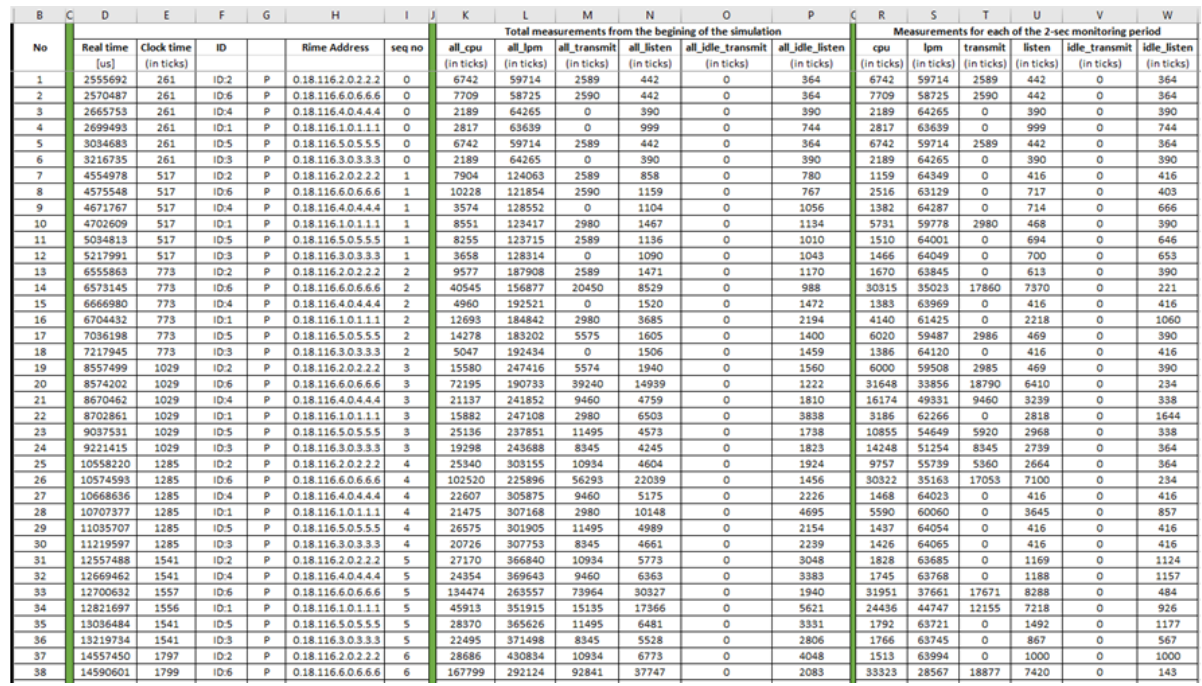
Figure 28. Malicious “pwrtrace.csv”— 1 to 38 records. Sensors 2020 , 20 , x FOR PEER REVIEW